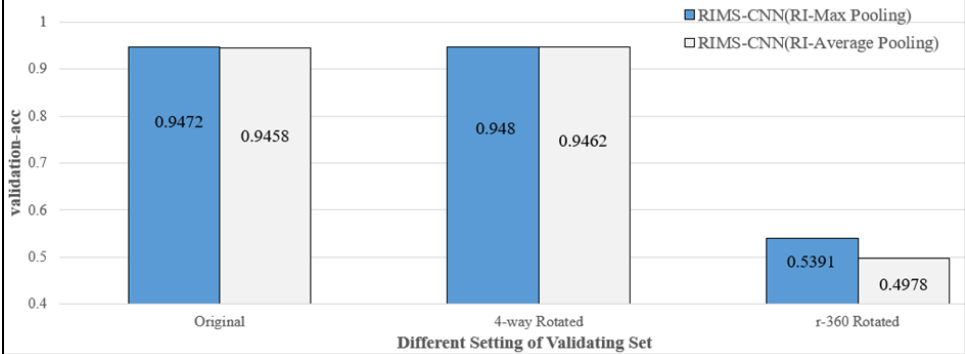
Figure 20. Comparing RI-max pooling with RI-average pooling in the different MNIST settings.